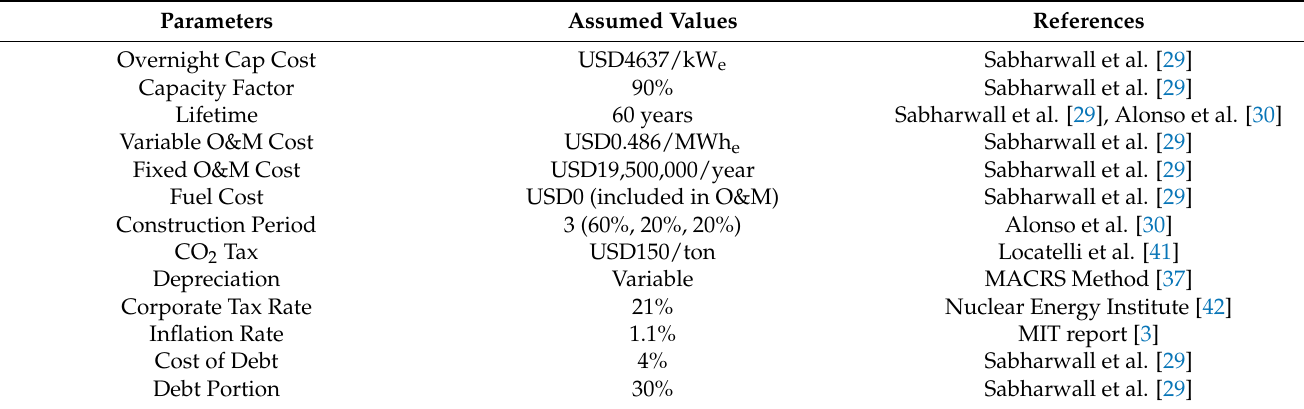
Table 3. Parameters Assumed for this